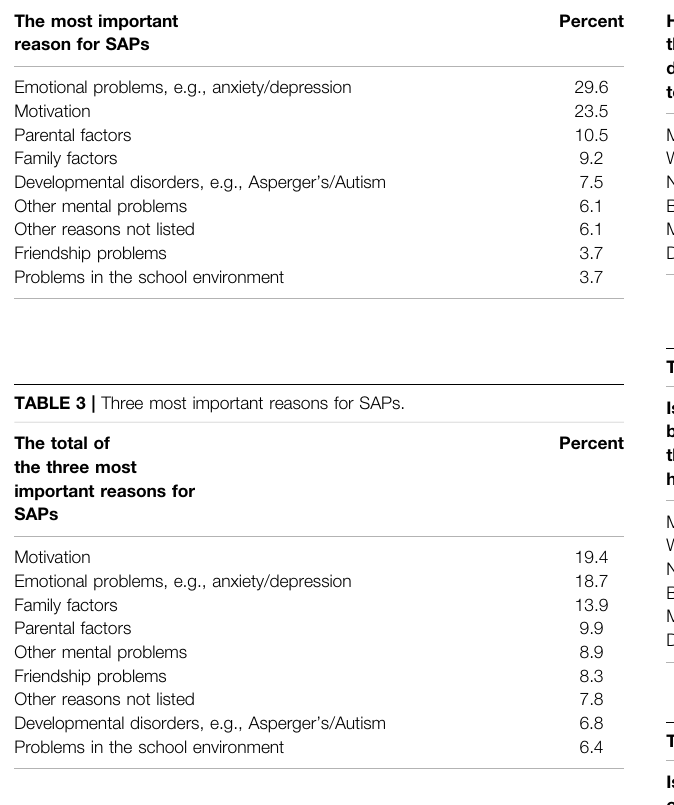
TABLE 5 | Experiences of participation during homeschooling.